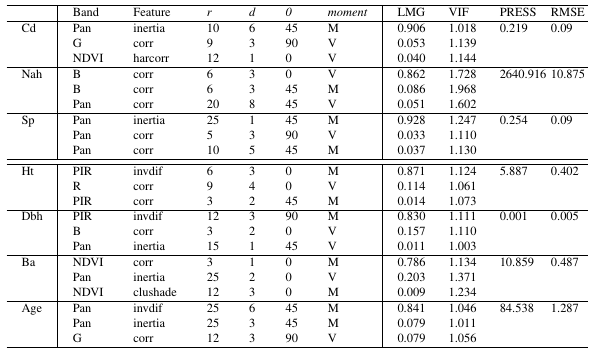
Table 6: Multiple solutions combining panchromatic and multispectral data ( n = 12 )